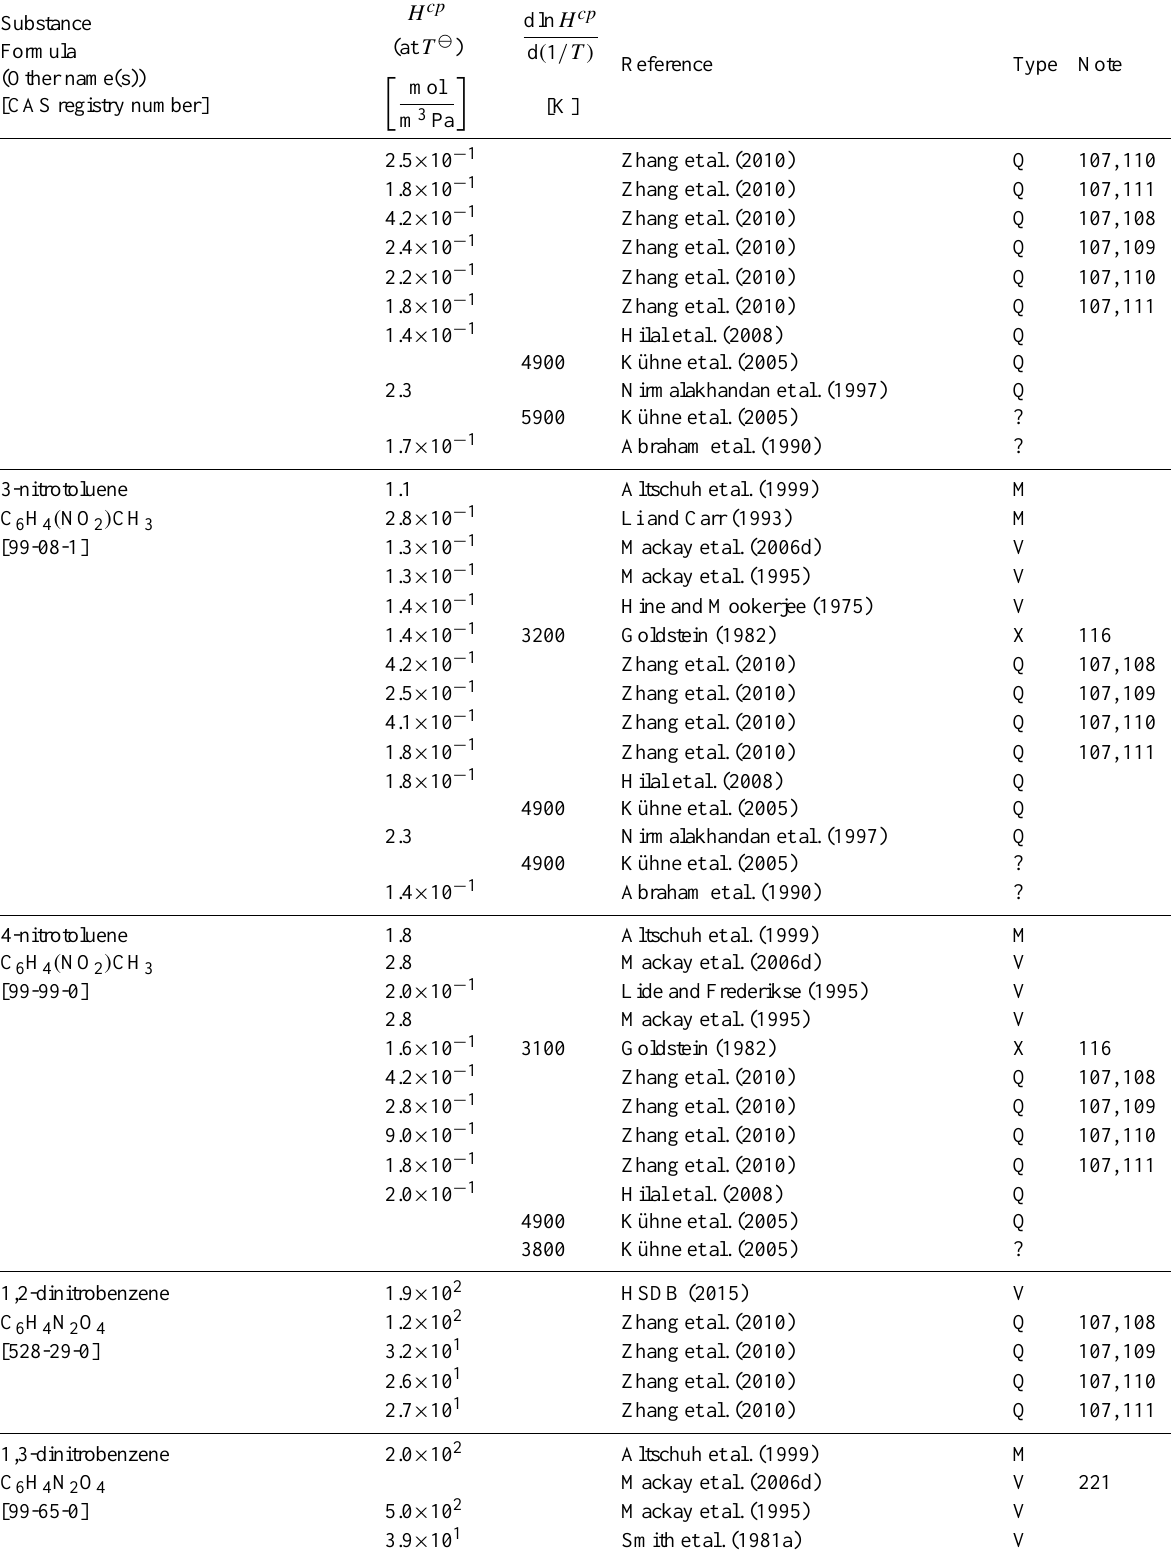
Table 6: Henry’s law constants for water as solvent